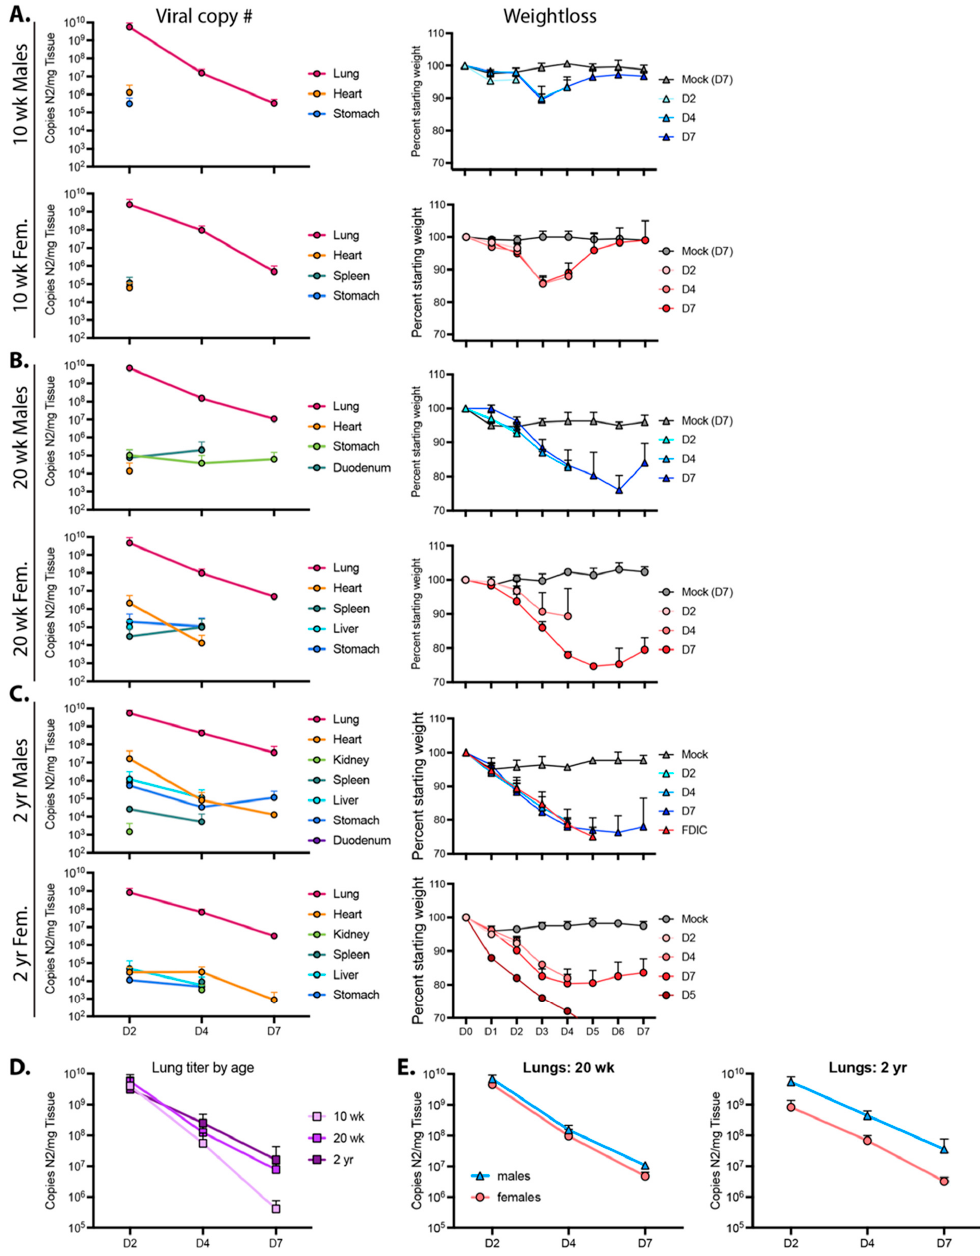
Figure 4. Viral reads and weight loss from 10 wk-old ( A ), 20 wk-old ( B ), and 2 yr-old ( C ) male and female mice infected with the R2G variant. Viral reads were determined by qPCR for copies of Nucleocapsid RNA (N2) per mg tissue, which was collected 2, 4, or 7 days post infection, with 3 mice per cohort. Tissues that are positive for viral reads are graphed for each cohort, and Ct cut off of 34 was determined from standard curves. Of note, while all mice at all time points were positive for virus in the lung, this was not the case for other tissues, where positivity may have been confined to one or two mice with the cohort. These data are presented in Supplemental Table S1. Additionally, shown are weight loss for animals used to determine the number of viral read per tissue. Male (blue triangles) and female (pink circles) animals euthanized 2, 4, or 7 days post infection are shown as D2, D4, and D7, respectively. Of note, data from D7, 2 yr-old males may under-represent true disease severity as many 2 yr-old males succumbed to infection or met euthanasia criteria on day 5 post infection and data from D7 2 yr-old males could only be surveyed from survivors. ( D , E ) Lung titers from ( A – C ) with sexes combined ( D ) or separated ( E ); lung titers were not significantly different between age and sex by 2-way